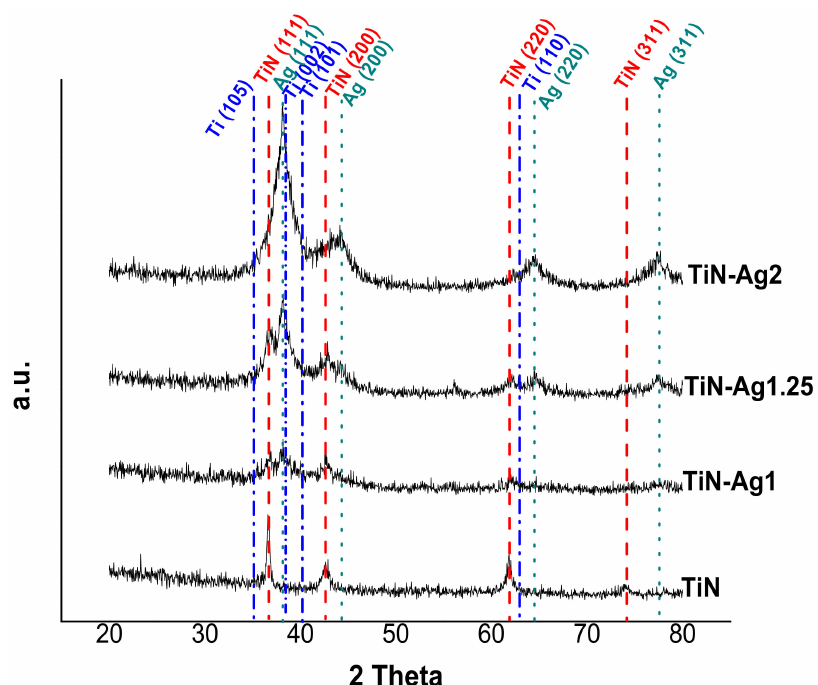
Figure 3. XRD patterns of TiN-Ag coatings deposited with different silver content (Cu K α radiation).